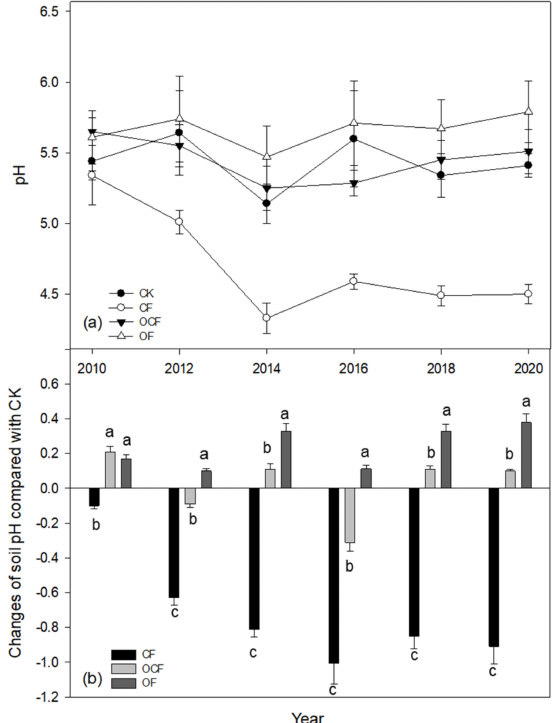
Figure 1. Trend of soil pH during the ten years ( a ) and changes of soil pH compared with CK ( b ) under different fertilization treatments. CK, no fertilization; CF, single application of chemical fer-tilizer; OCF, application of organic-inorganic fertilizer; OF, single application of organic fertilizer. Values with the same lowercase letter are not significantly different among the different fertilization treatments in the same